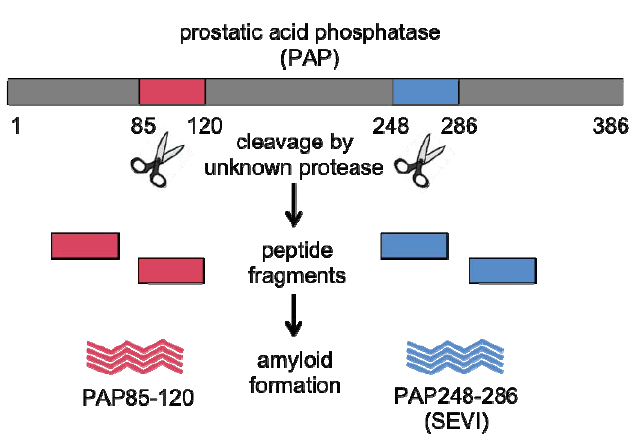
Figure 1. Proteolytic cleavage of prostatic acid phosphatase (PAP). Full-length PAP, a protein present at high concentrations in semen, undergoes proteolysis to form peptide fragments PAP85-120 and PAP248-286. These peptide products readily aggregate and assemble into amyloid fibrils in seminal fluid. Amyloid fibrils formed from PAP248-286 are termed SEVI (Semen-derived Enhancer of Viral